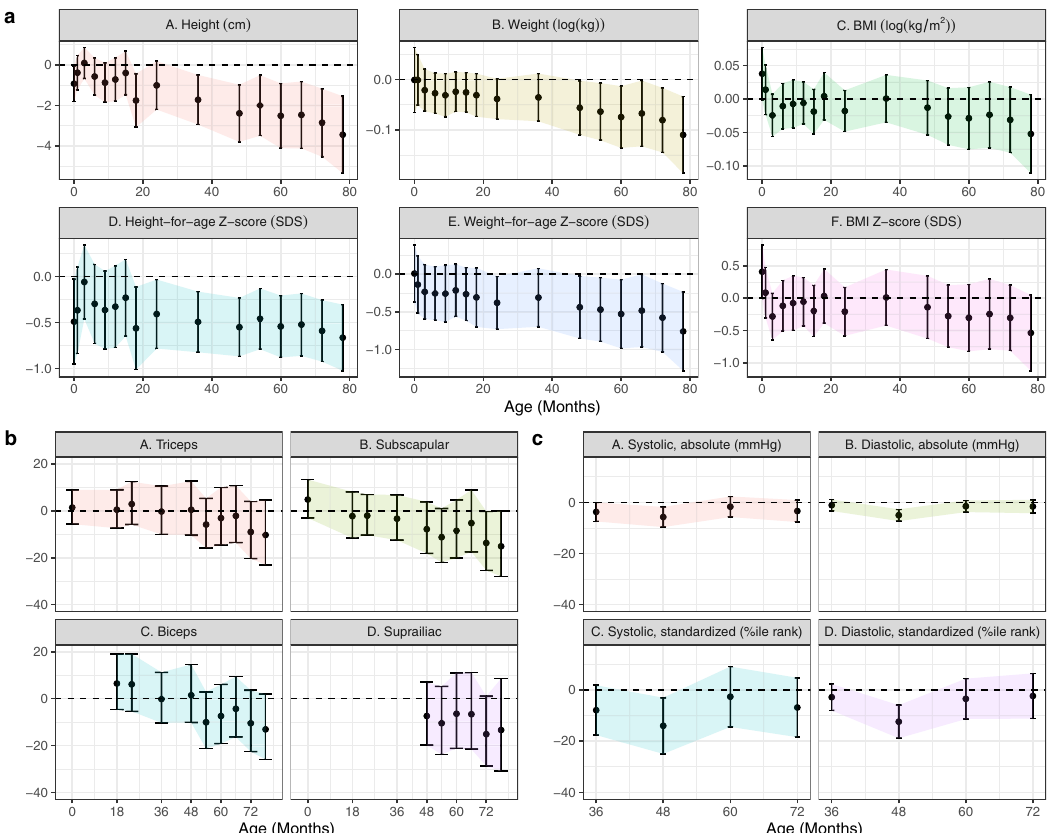
Fig. 3 Difference in anthropometrics, skinfold thickness, and blood pressure comparing ART-conceived fetuses versus a putatively subfertile cohort, adjusted for pre-pregnancy characteristics. Point estimates and Wald-type 95% con fi dence intervals show the adjusted mean difference in anthropometric ( a ), skinfold thickness ( b ), and blood pressure ( c ) measures between ART-conceived and spontaneously conceived (SC) children from a subfertile cohort ( N = 93) selected on the basis of medical history that may prompt couples to seek fertility specialist care including the history of two